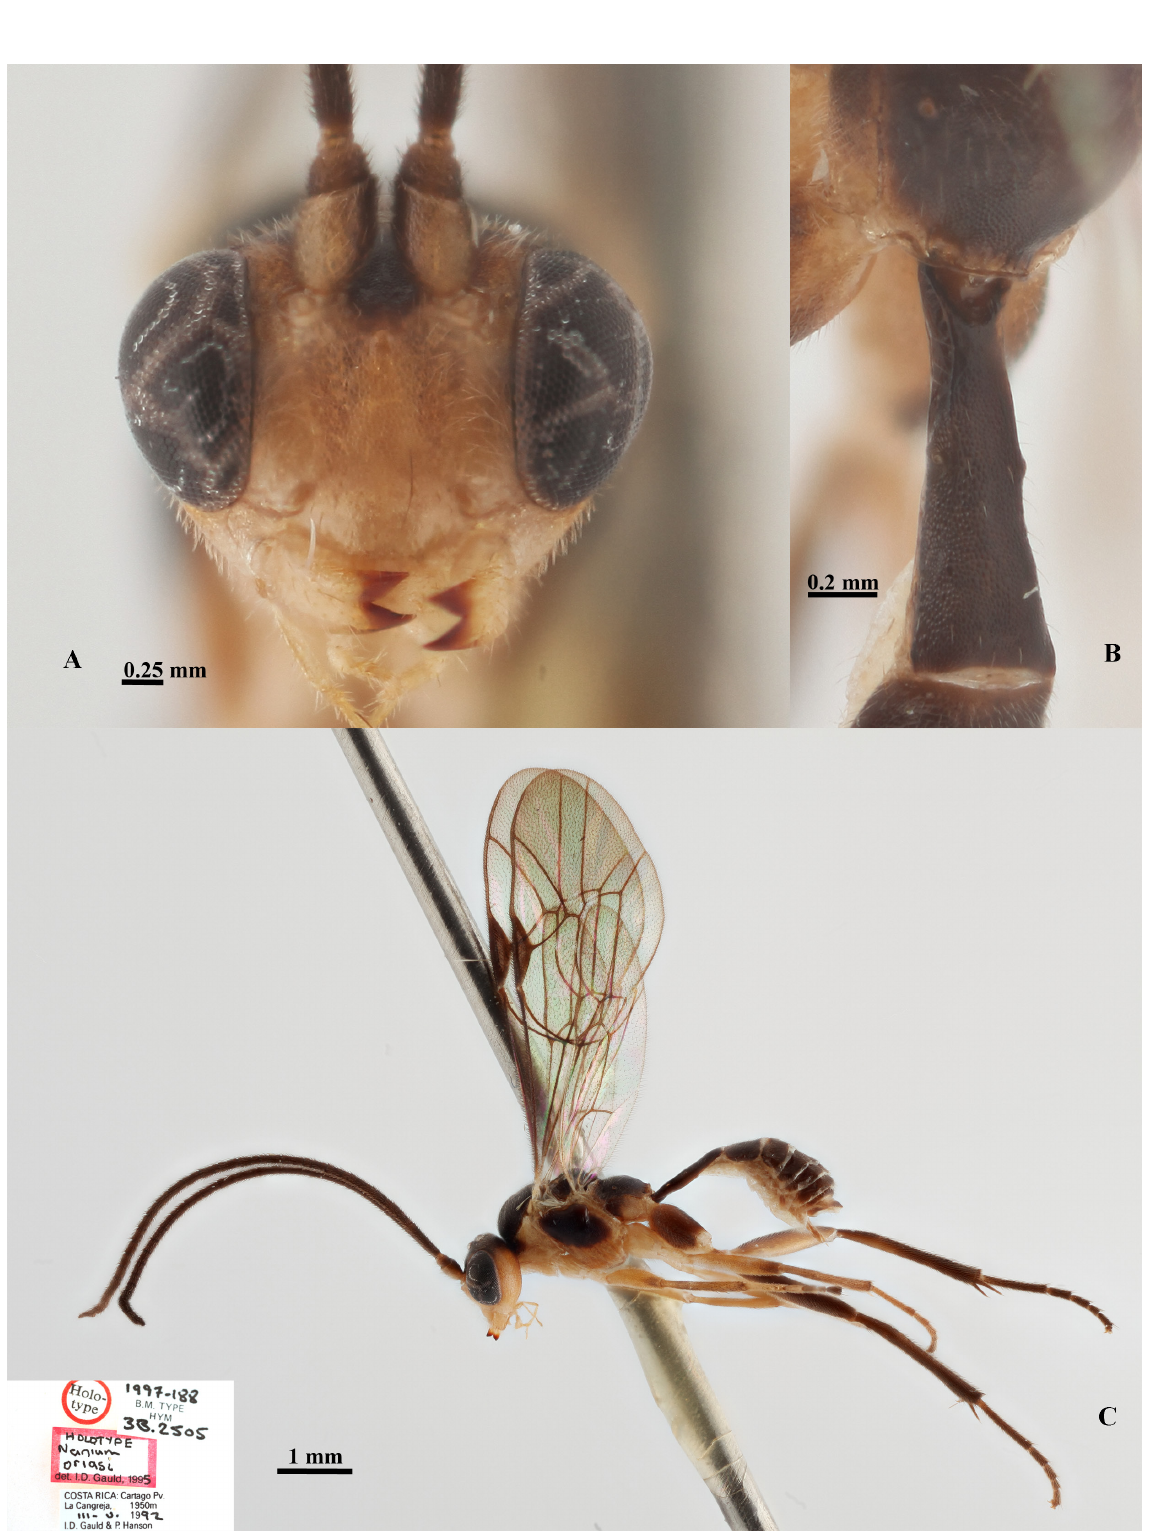
Fig. 7 . Nanium oriasi Gauld, 1997, holotype, ♀ (BMNH). A . Face. B . Metasoma (dorsal view). C .